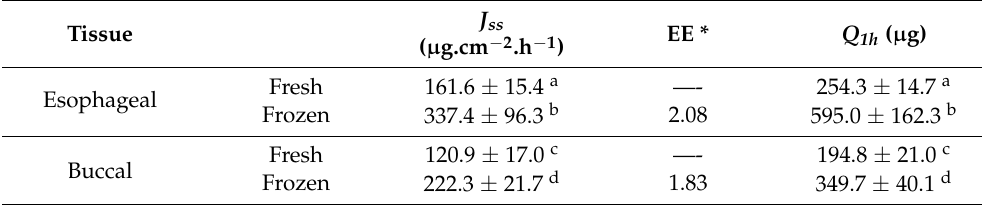
Table 1. Calculated steady-state fluxes ( J ss ) and cumulative amounts of LDH permeated after 1 h ( Q 1h ) for permeation across the different mucosas, under infinite dose conditions ( n = 9–10; R 2 > 0.98). * EE: enhancement effect comparing the mean J ss values for the fresh and frozen tissues.